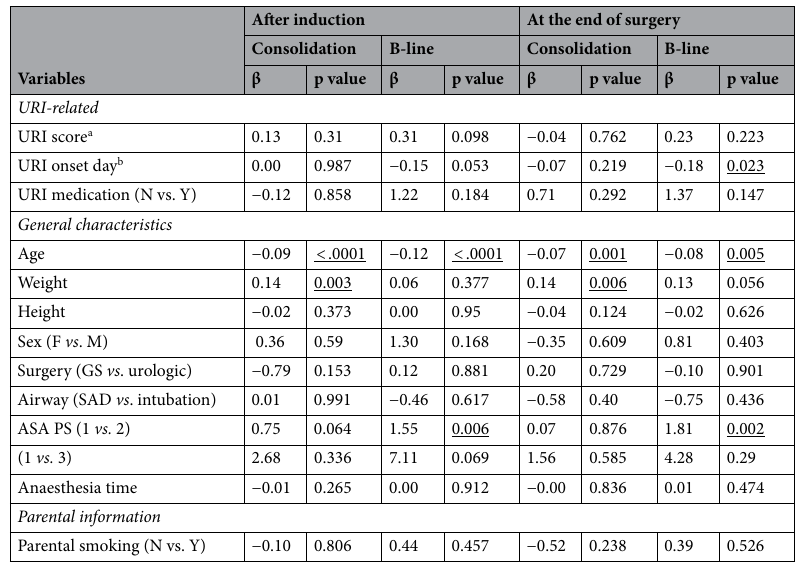
Table 3. Multivariable analysis of factors associated with the atelectasis score measured at the post-induction and before-emergence periods using transthoracic lung ultrasonography. Values are presented as coefficient; β and p value. URI; upper respiratory infection, N; no, Y; yes, F; female, M; male, GS; general surgery, SAD; supraglottic airway device, ASA PS; American society of anaesthesiologists physical status. a Range of data: from 0 to 24. b Range of data: from 0 to 20.